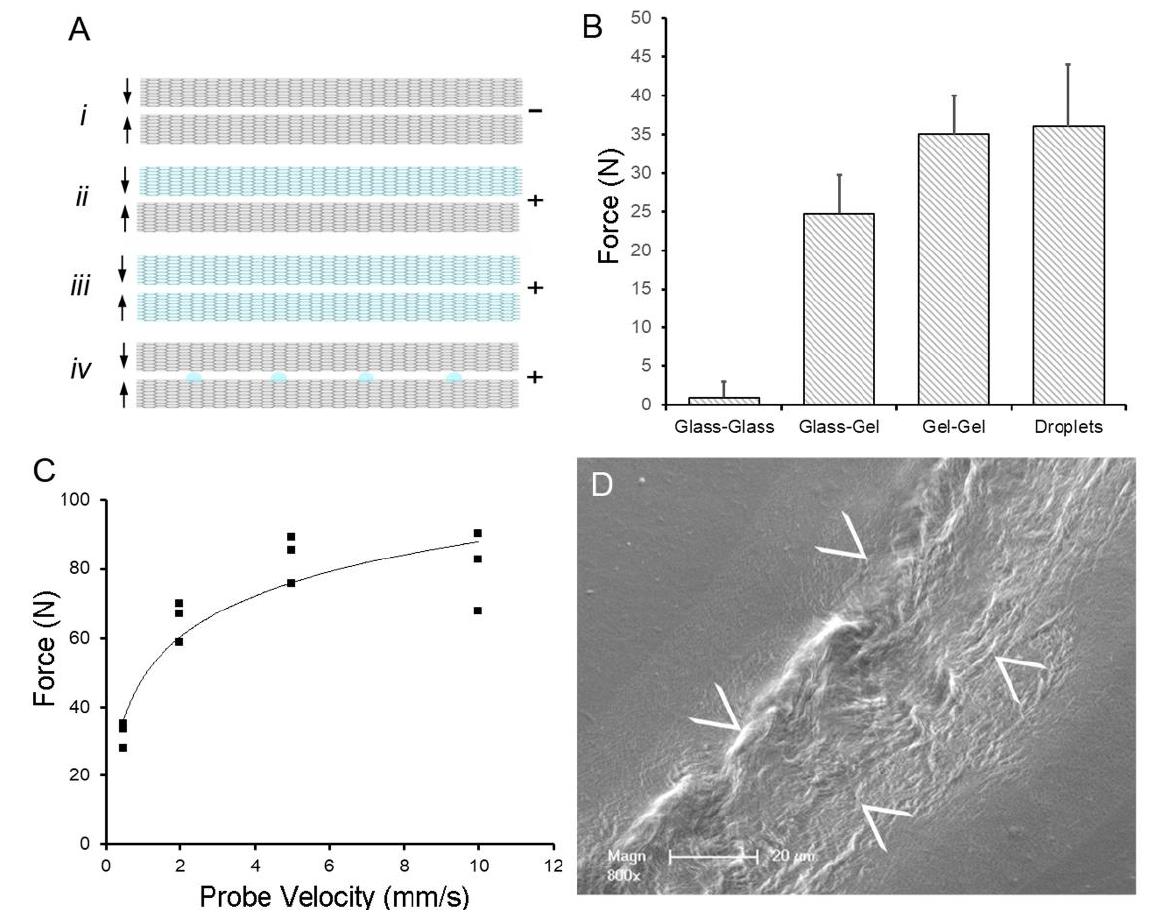
Figure 1. Water-induced adhesion of pectin films cured in parallel. ( A ) Schematic of pectin films in glass phase (gray) and gel phase (blue). The (–) indictes no adhesion, whereas (+) indicates an adhesive interaction between films. ( B ) Using a previously defined adhesion assay [35], pectin films were gently compressed (5N) for a 60 s development time followed by withdrawal of the films at 0.5 mm/sec. Two glass phase films (A i ) demonstrated no adhesion. Hydration of one (A ii ) or both (A iii ) of the films to 15% water content resulted in significant adhesion. An equal volume of water placed on the glass phase films as droplets (A iv ) resulted in comparable adhesion to two gel films. ( C ) In the droplet assay, adhesion was largely independent of probe speed (that is, the speed at which the films were compressed). ( D ) Scanning electron microscopy (SEM) of two films following droplet compression shows evidence of polymer chain entanglement at the film interface (arrows at film interface).